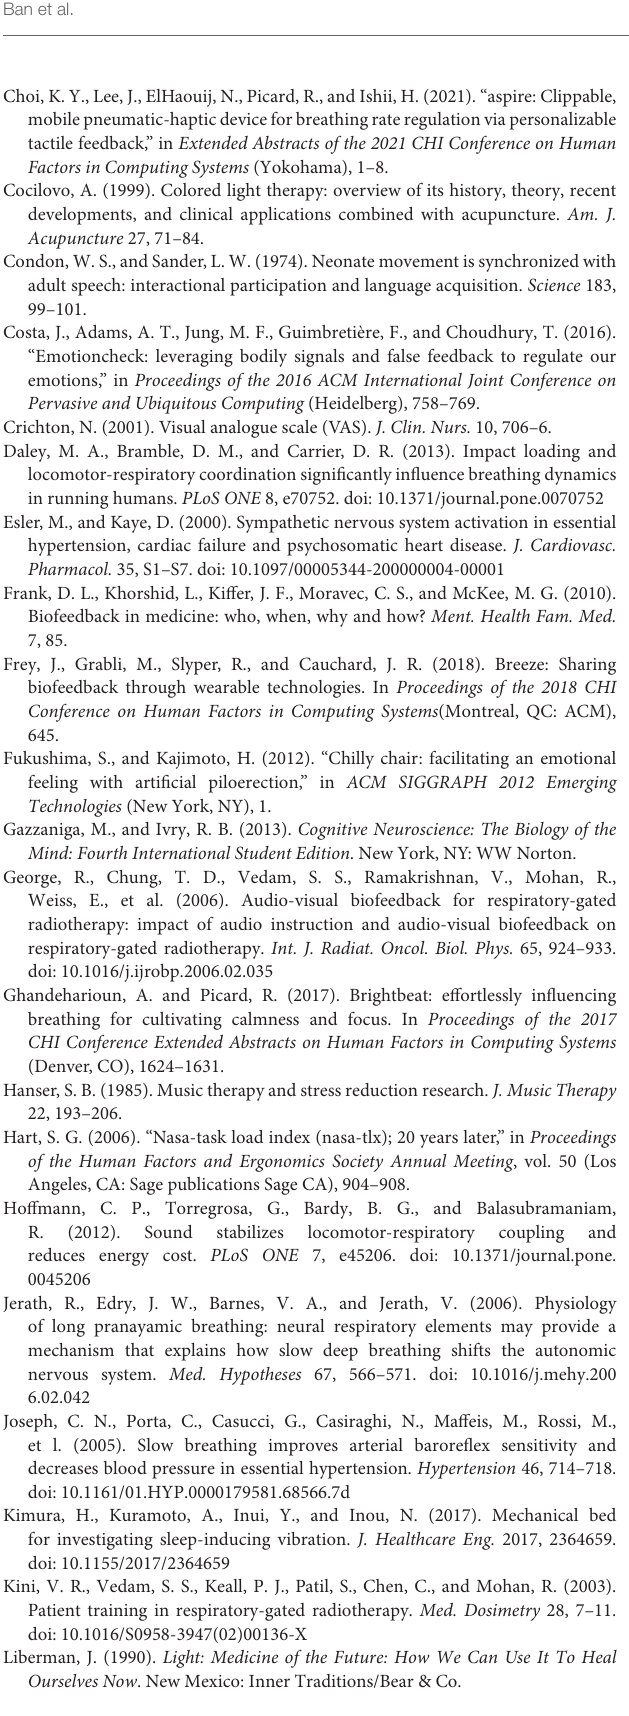
Tabor, A., Bateman, S., Scheme, E., Sadprasid, B., and Schraefel, M. (2021). “Understanding the design and effectiveness of peripheral breathing